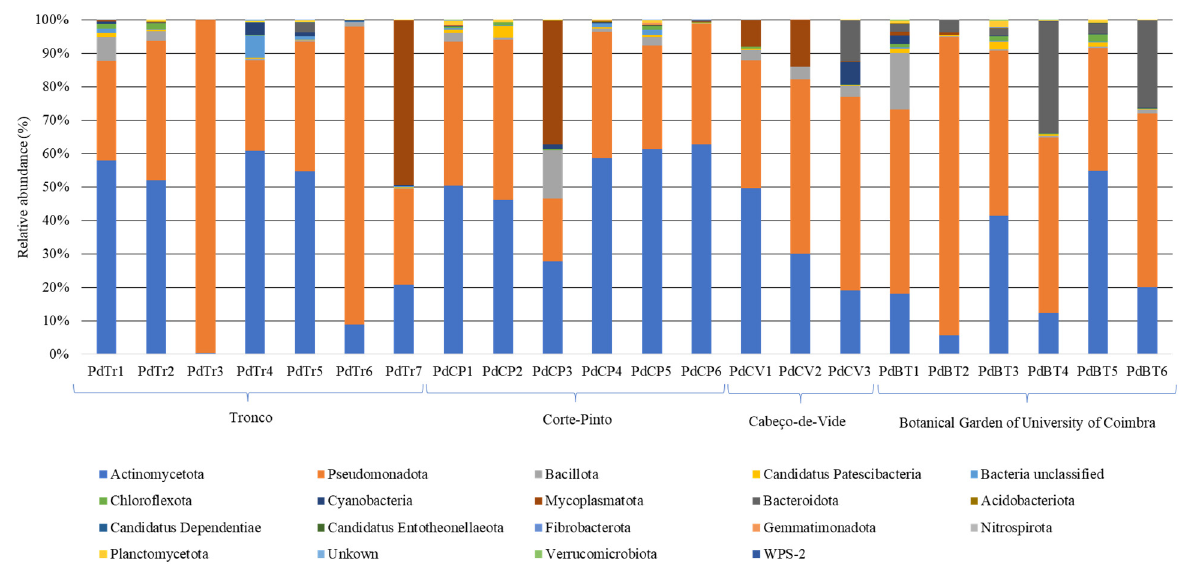
Figure 1. Composition of Porcellio dilatatus gut bacterial communities, at the phylum level. Relative abundance of sequences present in the P. dilatatus guts sampled from Tronco (PdTr); Corte-Pinto (PdCP); Cabeço-de-Vide (PdCV) and Botanical Garden of University of Coimbra (PdBT). Sequences that could not be classified in any known phyla were assigned as bacteria unclassified and